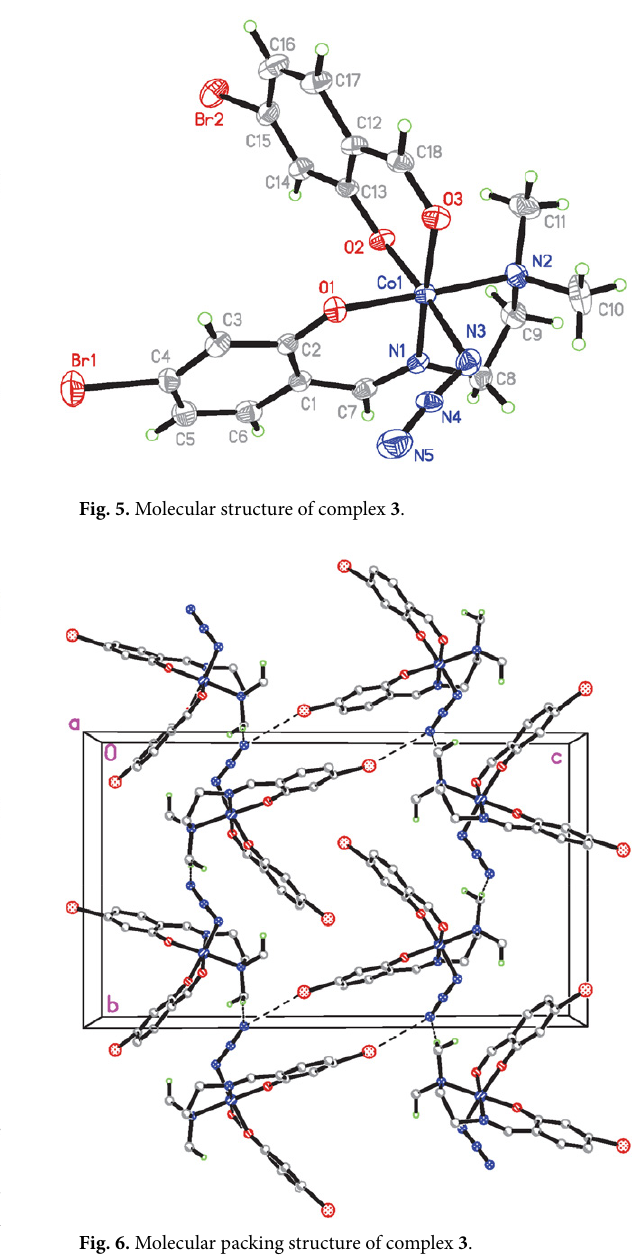
Fig. 6. Molecular packing structure of complex 3